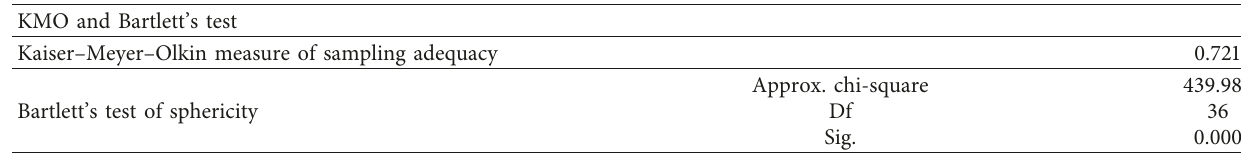
Table 7: KMO and Bartlett’s test measure of sampling adequacy.